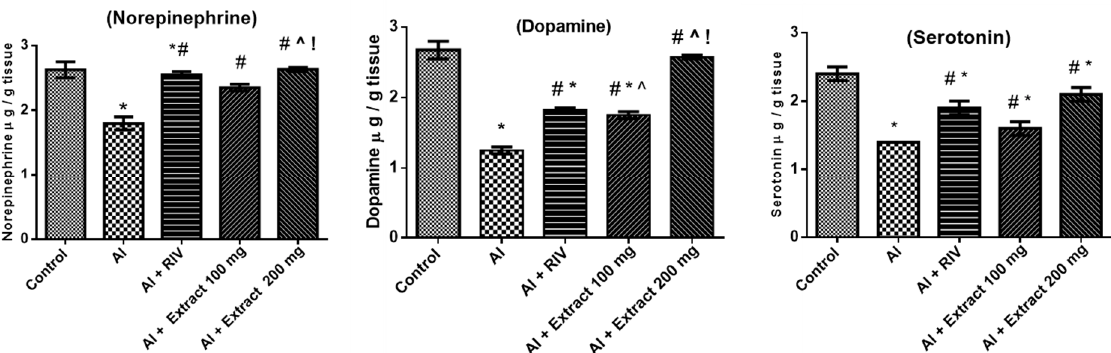
Figure 4. Effect of H. abyssinica extract on the levels of norepinephrine, dopamine and serotonin. * Significant difference from control group at p ˂ 0.05, # significant difference from AlCl 3 group at p ˂ 0.001, ^ significant difference from RIV group at p ˂ 0.001, ! significant difference from 100 mg group at p ˂ 0.05. Mean ± SE.